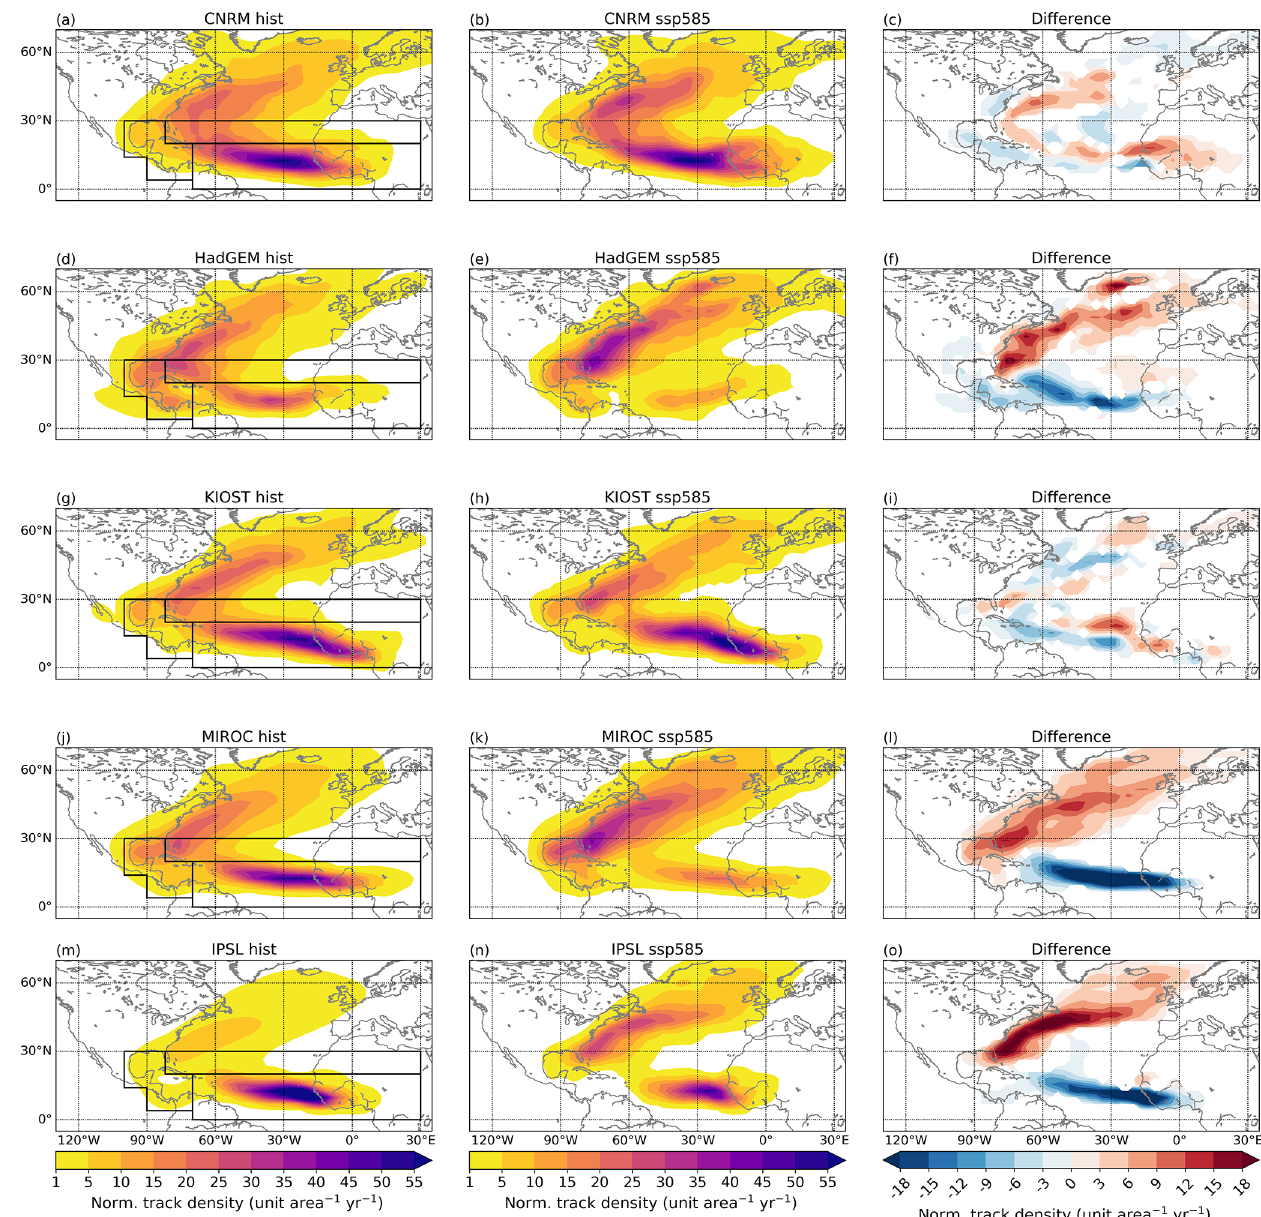
Figure 7. Normalized TC track density for the five selected CMIP6 models during the historical (first column) period, towards the end of the century under SSP5-85 (middle) and the difference (future minus historical, right column). Densities less than 1 have been masked for clarity. Black domains represent the boundaries of the MDR, SUB, and WEST